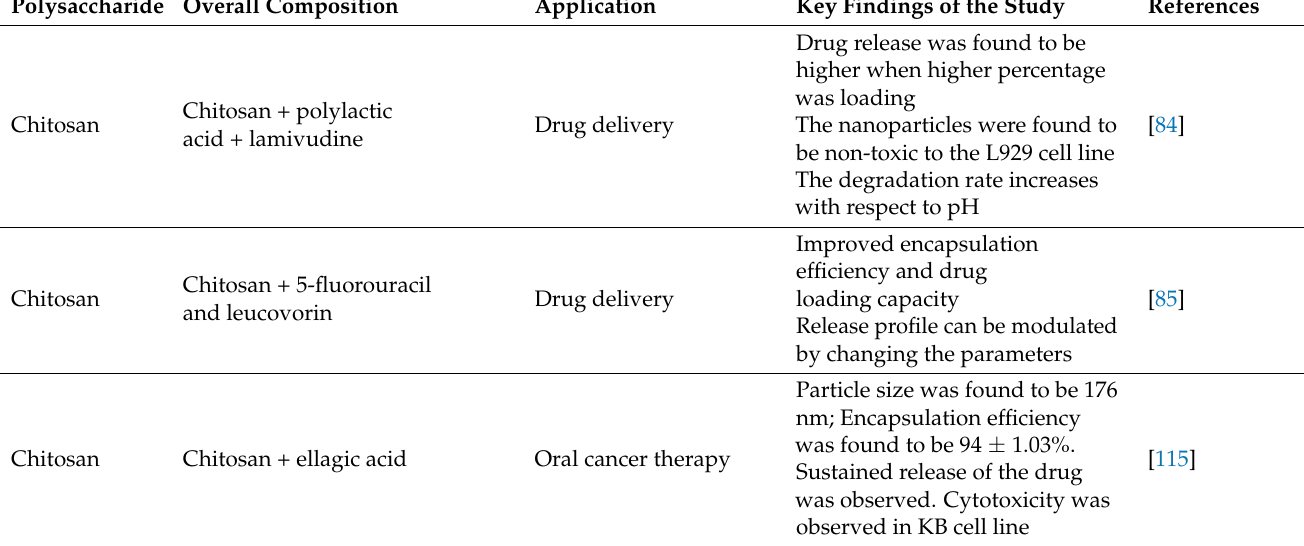
Table 3. Summary of polysaccharide-based polymeric